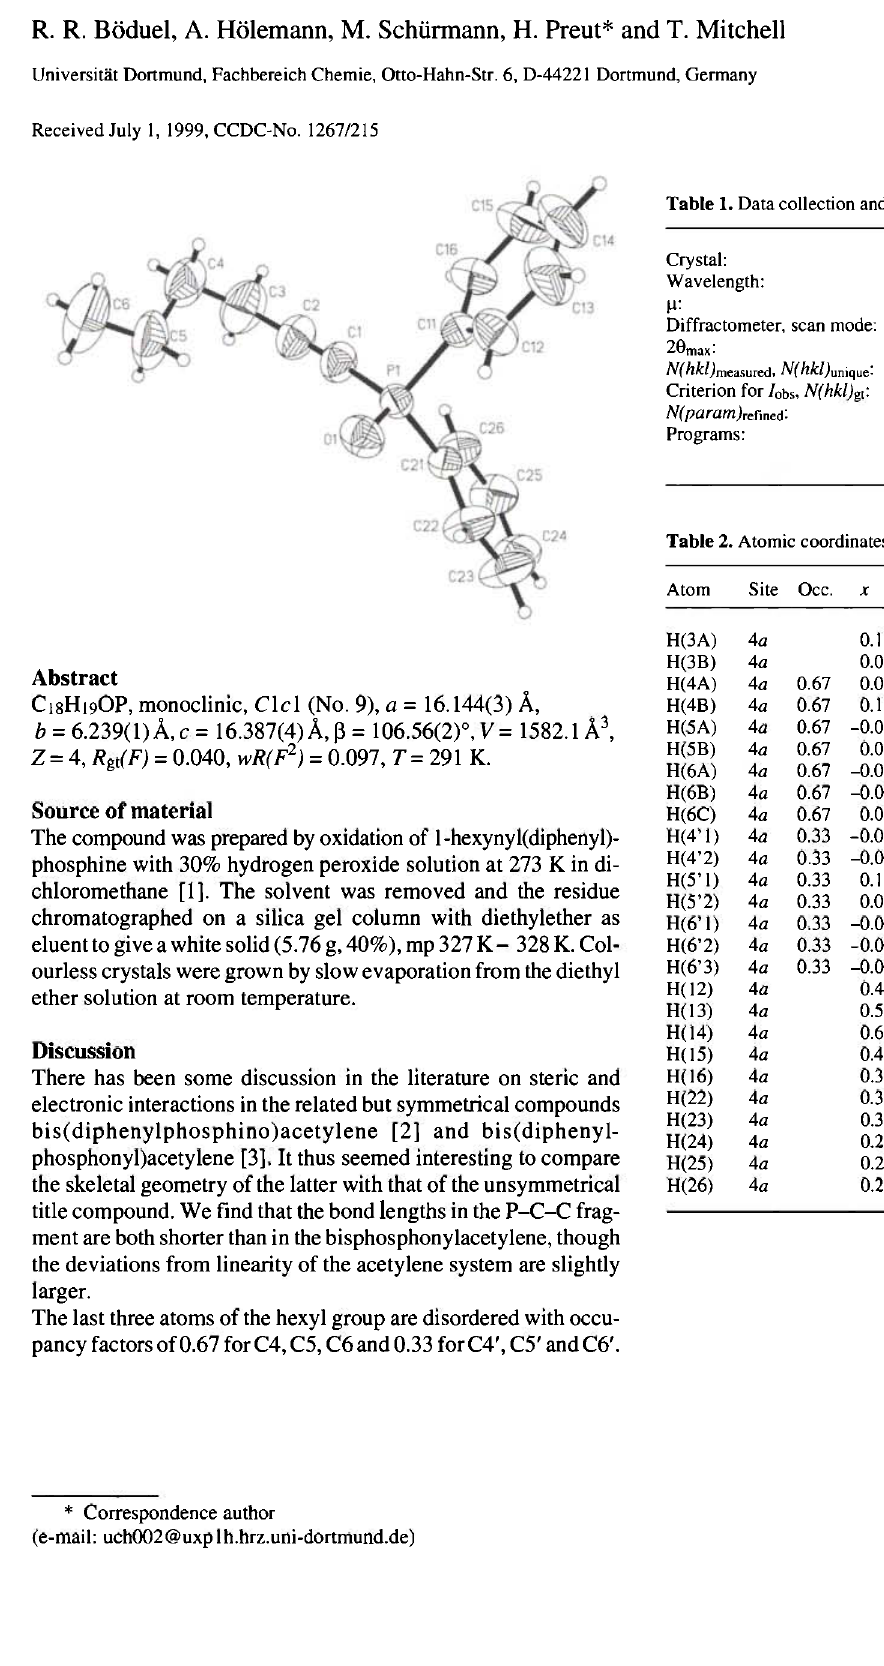
Table 1. Data collection and handling.